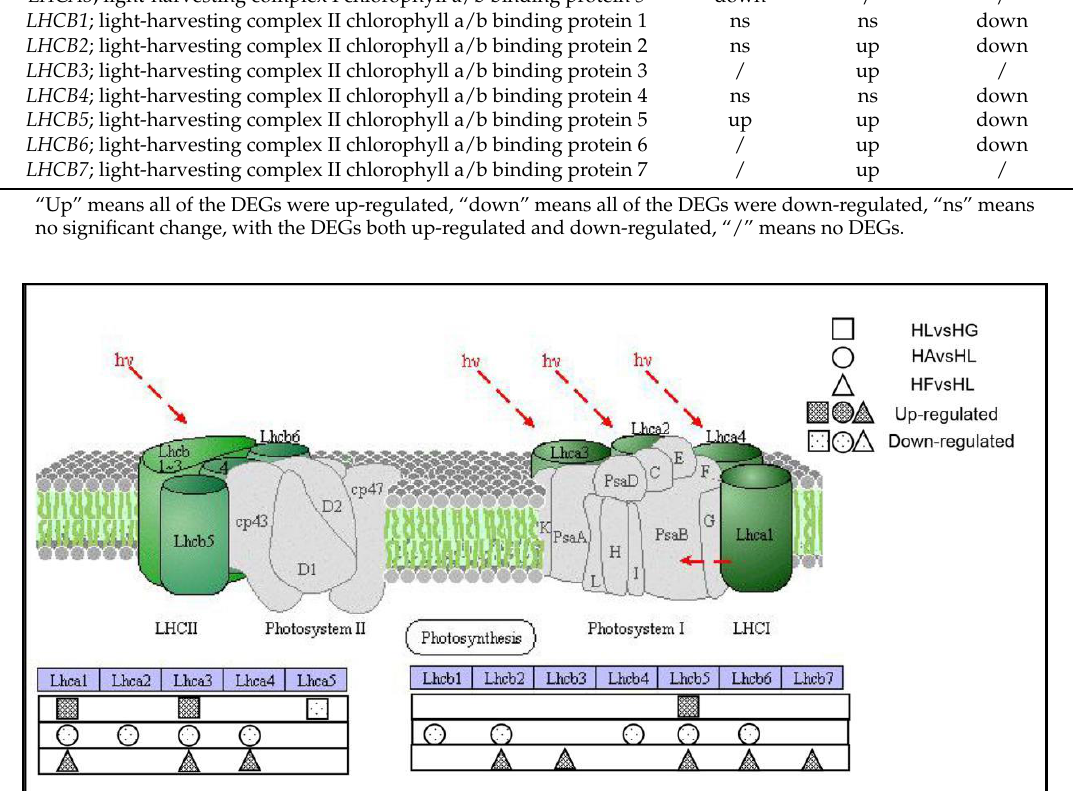
Figure 9. The pathway for photosynthesis-antenna proteins. hv : light energy; Lhca1 –5: the genes encoding light-harvesting complex I chlorophyll a/b binding proteins 1–5; Lhcb1 –7: encoding light-harvesting complex II chlorophyll a/b binding proteins 1–7.